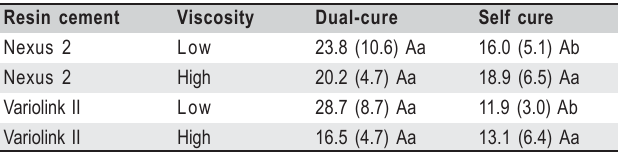
Table 2. Means (standard deviation) of bond strength to dentin for Nexus 2 and Variolink II resin cements as a function of viscosity and curing mode (in MPa).